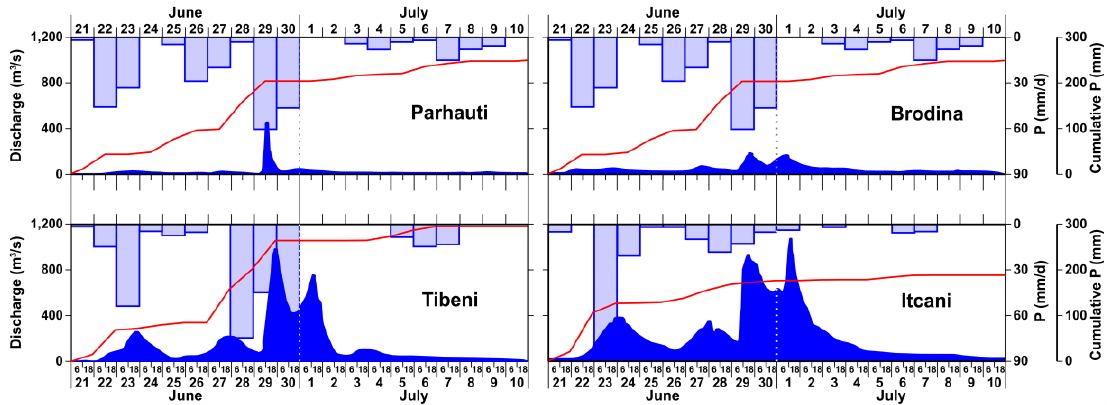
Figure 6. Hydrograph of flood waves and daily intensity of precipitation between 21 June and 10 July 2010, recorded at the hydrometric stations on the Suceava River.